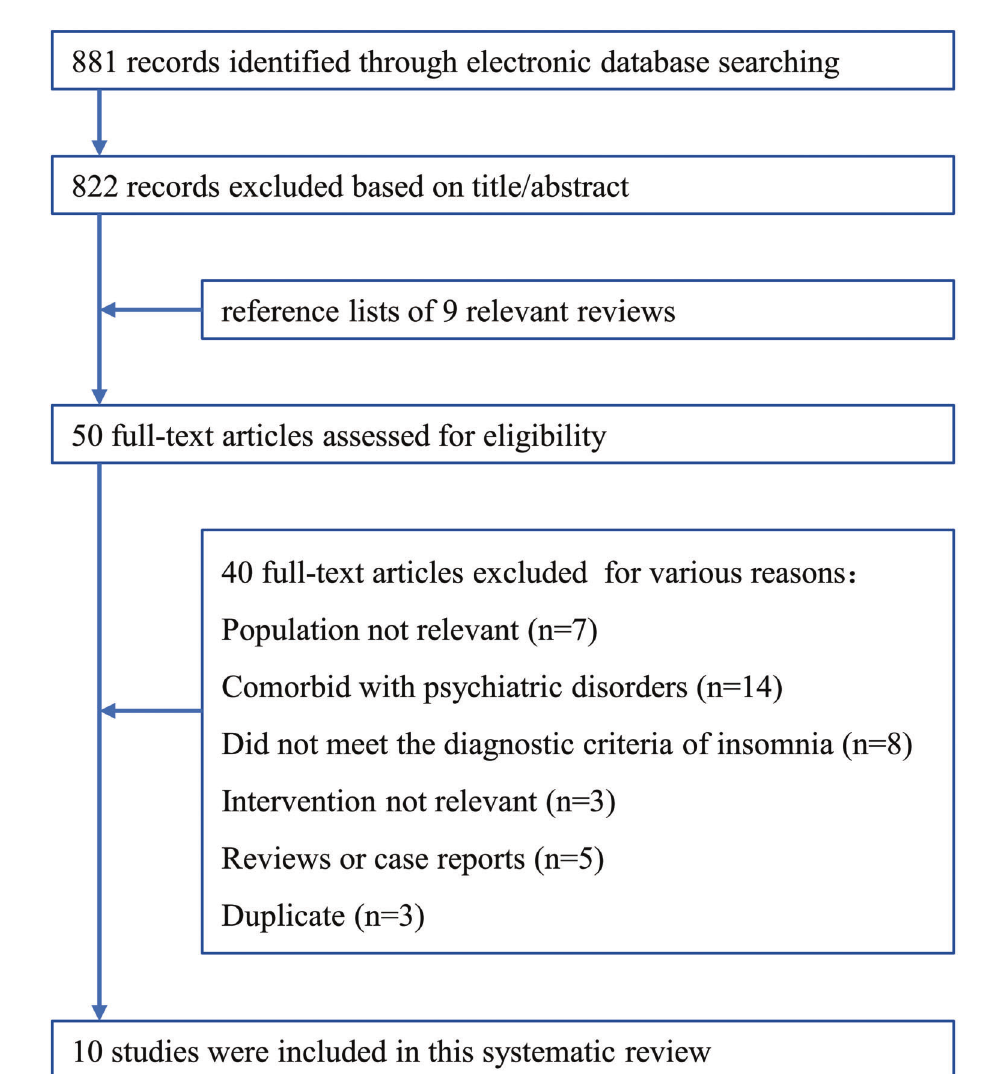
Figure 1. Flowchart of study